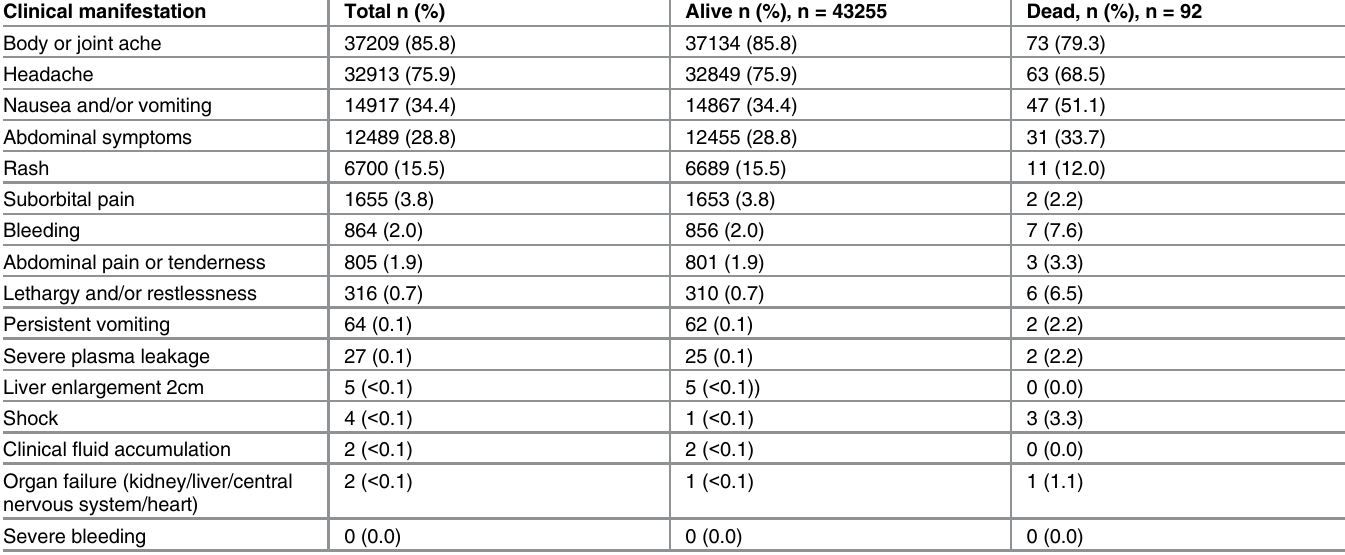
Table 2. Clinical manifestations at notification (n =